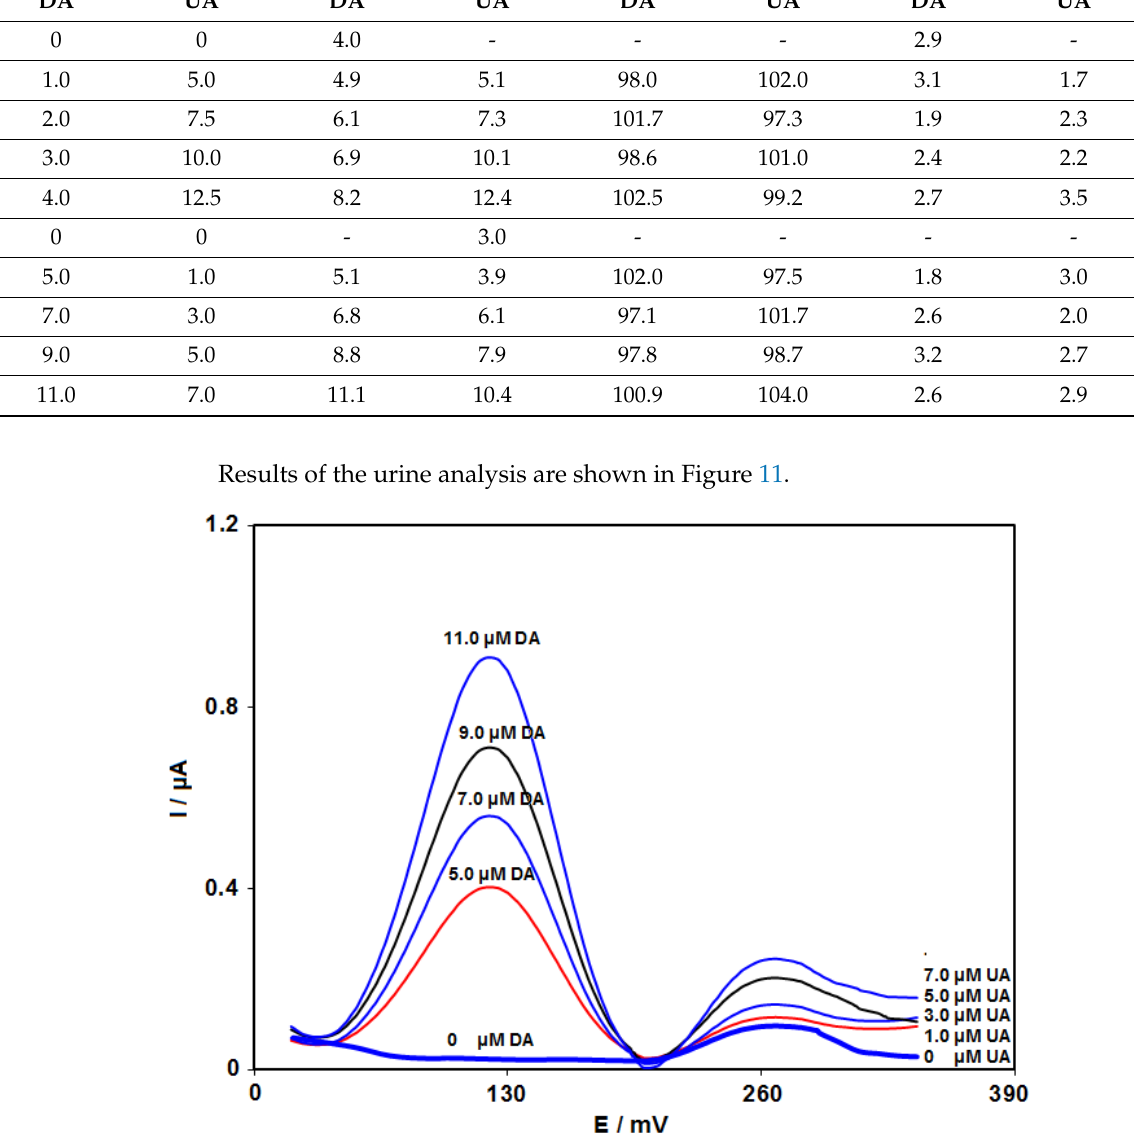
Table 3. Voltametric sensing of DA and UA in real specimens using CoMOF-GO/1-M,3-BB/CPE. All concentrations are in µA (n = 5).